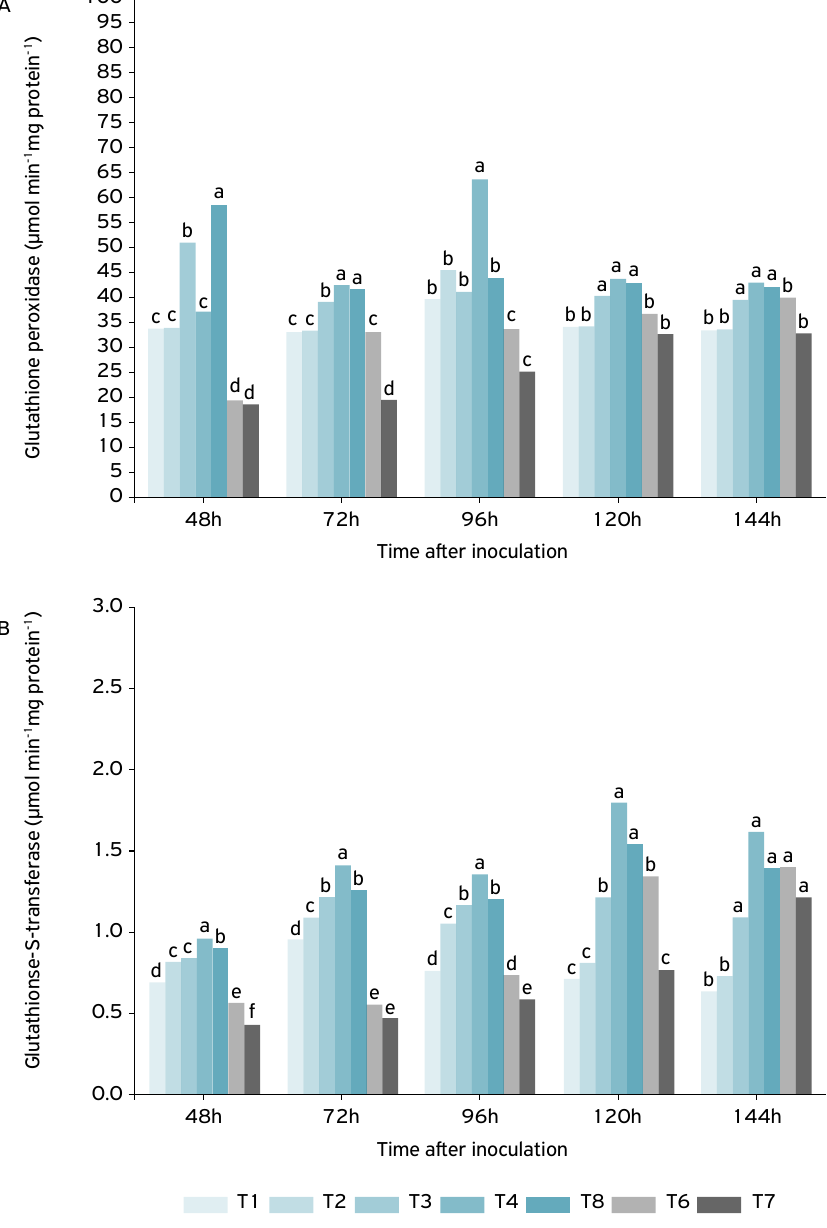
Averages followed by distinct letters between treatments differ by the Scott-Knott test at the 5% probability level; T1: suspension of Aspergillus japonicas ; T2: suspension of Trichoderma tomentosum ; T3: salicylic acid; T4: acibenzolar-s-methyl; T5: fungicide (Azoxystrobin with Tebuconazole); T6: application of sterile distilled water with inoculum of Bipolaris sorokiniana ; T7: without any Figure 4. Activity of the enzymes (A) glutathione peroxidase and (B) glutathione-S-transferase, after inoculation of the Bipolaris sorokiniana pathogen.